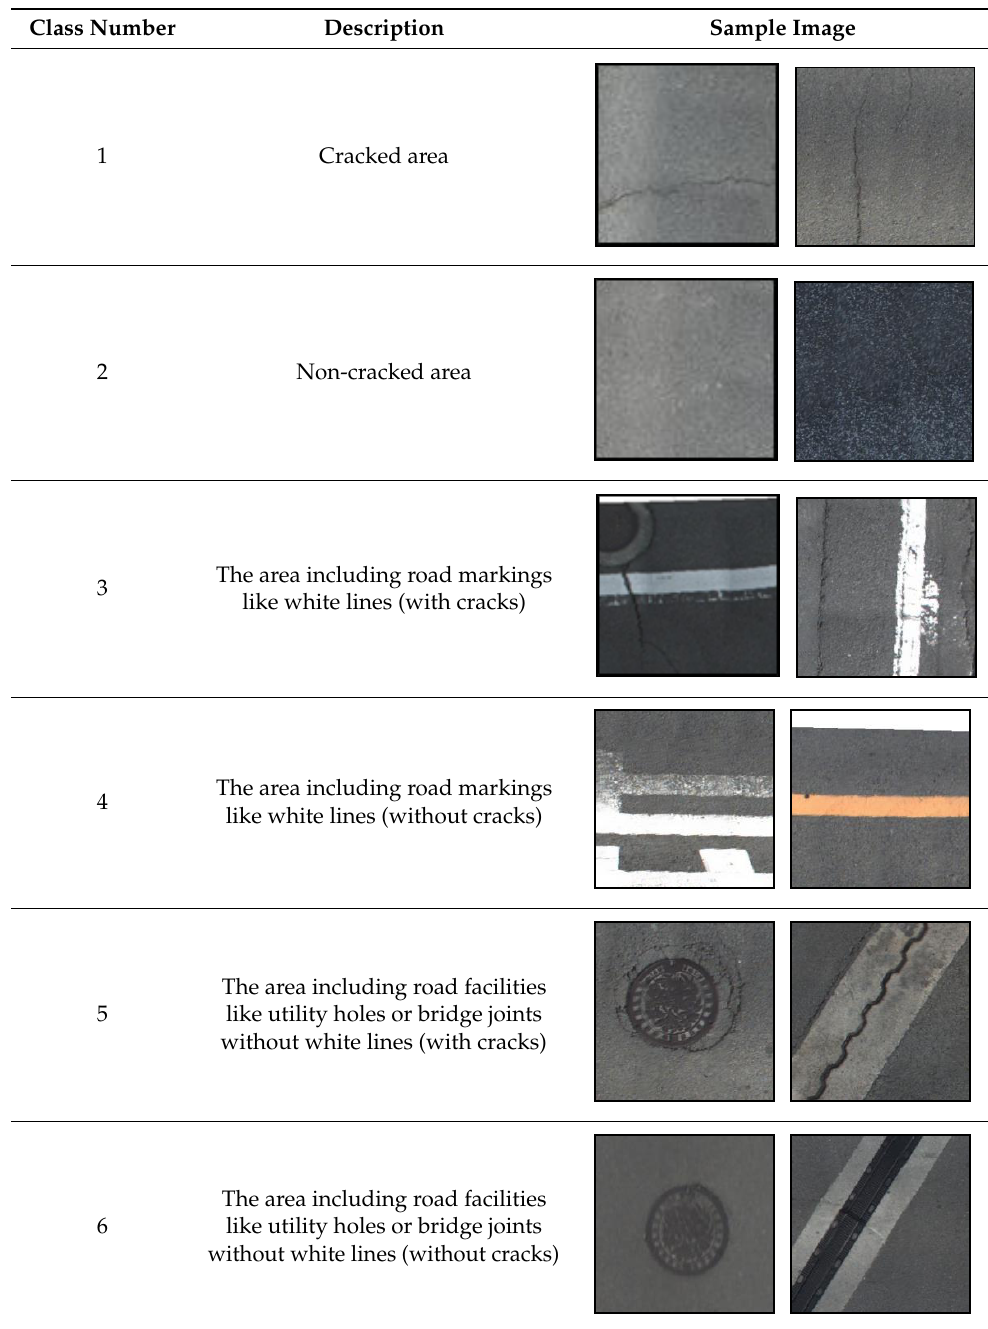
Figure 5. The flow of training and analysis with the CNN in this study. Table 1. Image classification.